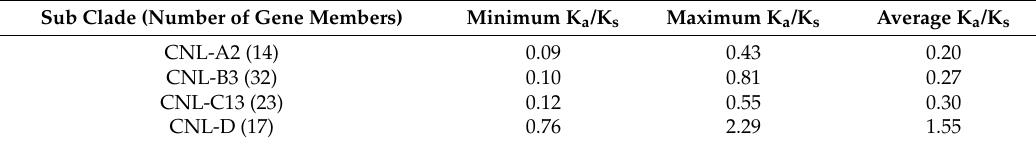
Table 5. Summary of K a /K s ratios for the nTNL gene members from CNL-A2, CNL-B3, CNL-C13 and CNL-D